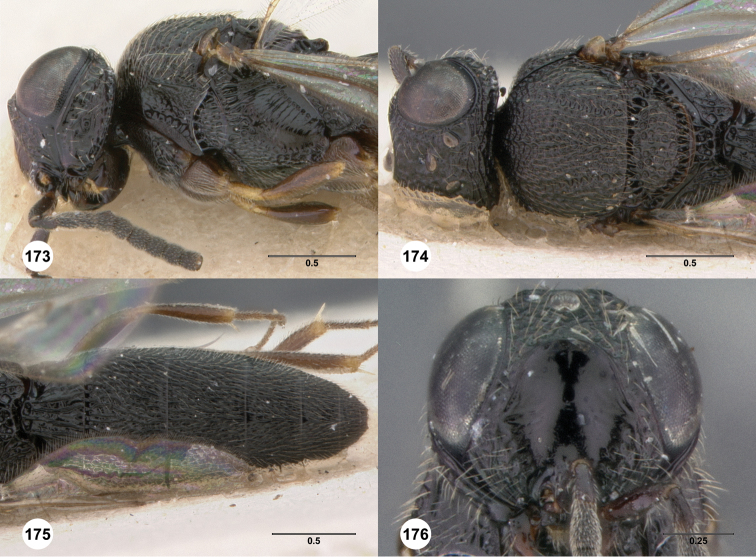
Oxyscelio lintris sp. n., holotype male (OSUC 453949) 173 Head and mesosoma, lateral view 174 Head and mesosoma, dorsal view 175 Metasoma, dorsal view. Paratype male (OSUC 453950) 176 Head, anterior view Morphbank61